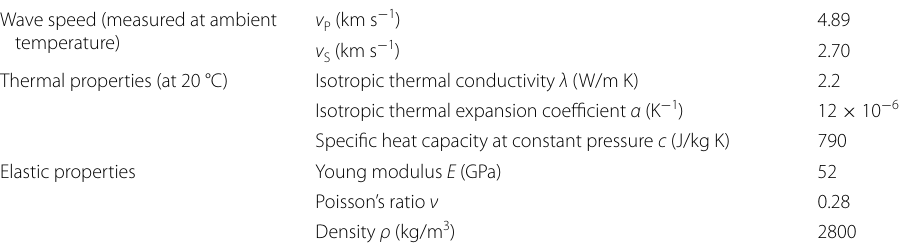
Young’s modulus, density and the thermal properties of the rock are chosen from Heard and Page (1982), Maqsood et al. (2004), Park et al. (2004), Dwivedi et al. (2008) and Schön (2011)